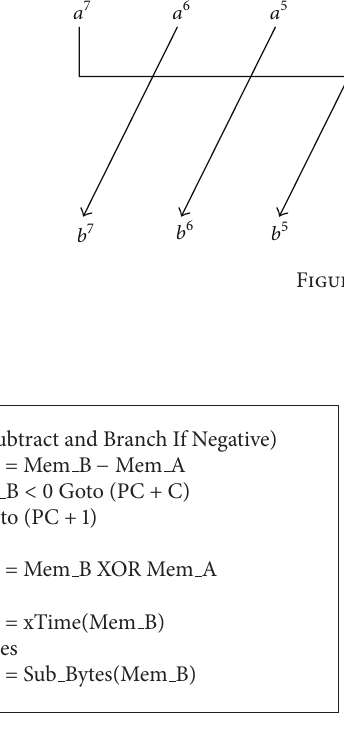
Algorithm 1: The CISA instruction sets in pseudocode form.